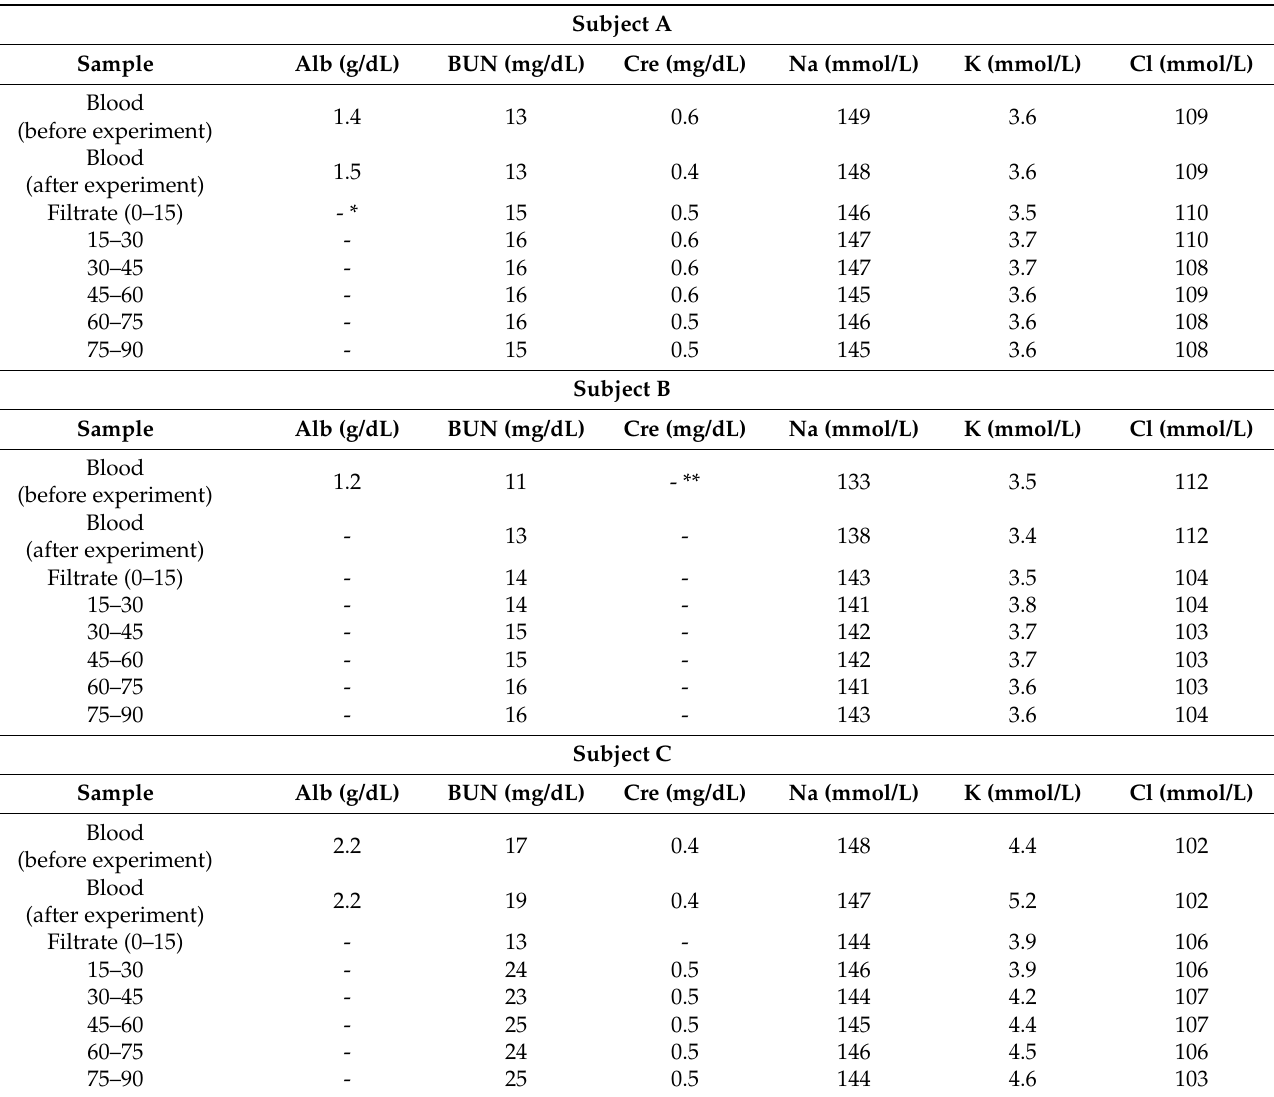
Table 3. Composition of blood and